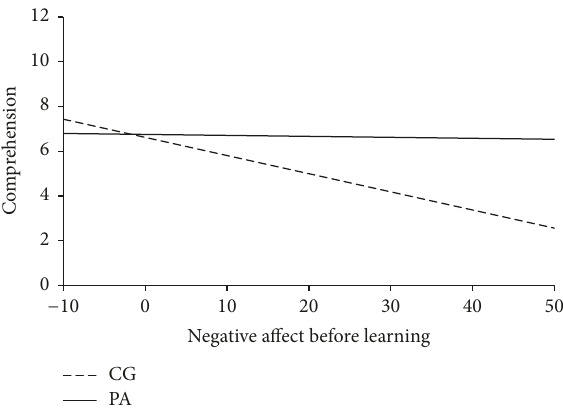
Figure 2: Regression of comprehension after learning on negative affect for the control group (CG) and the positive affect group (PA). Negative affect was centered; positive affect was held constantly at the average